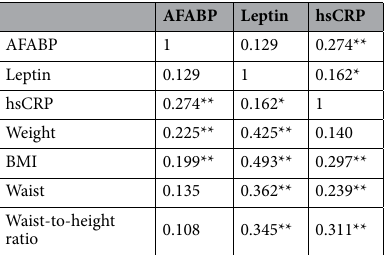
Table 2. Correlations between studied variables at the examination closest to IVF (n = 187). Values are Spearman rank correlation, ρ. * p < 0.05; ** p < 0.01.